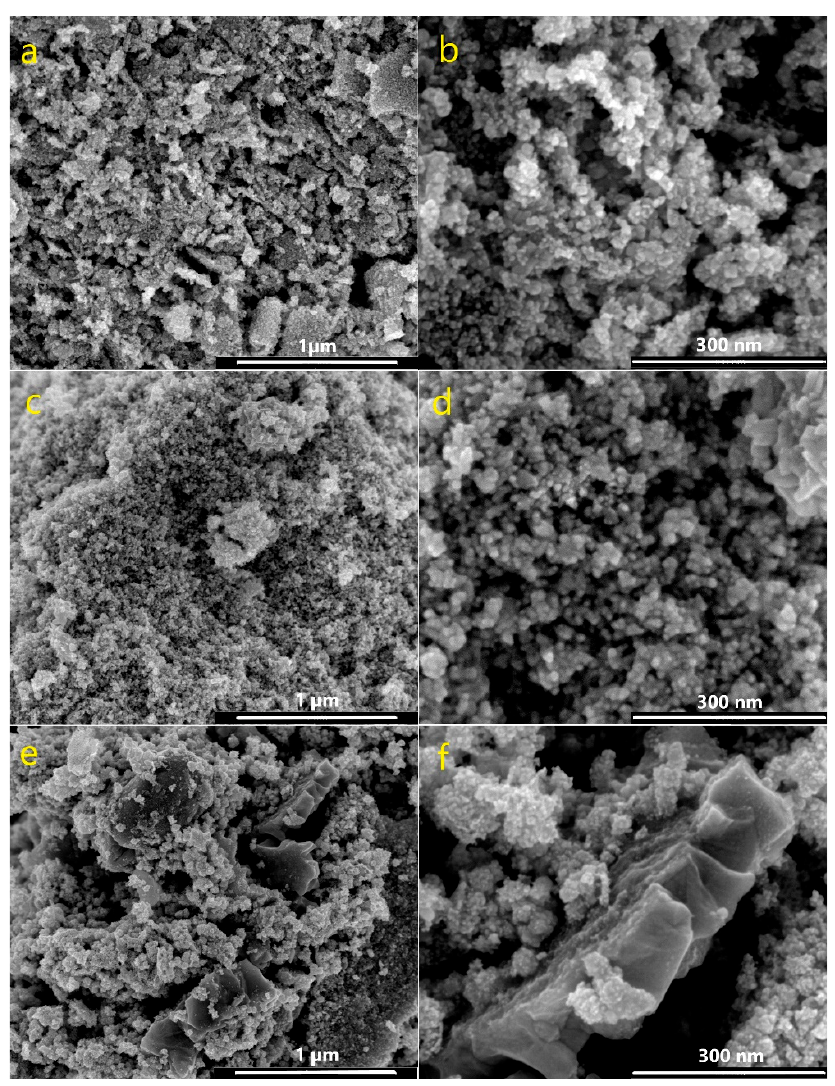
Figure 1. SEM micrographs of ATO: ( a ) 50,000× and ( b ) 200,000×. IrO 2 : ( c ) 50,000× and ( d ) 200,000×. Ir-Sn-Sb-O: ( e ) 50,000× and ( f ) 200,000×.